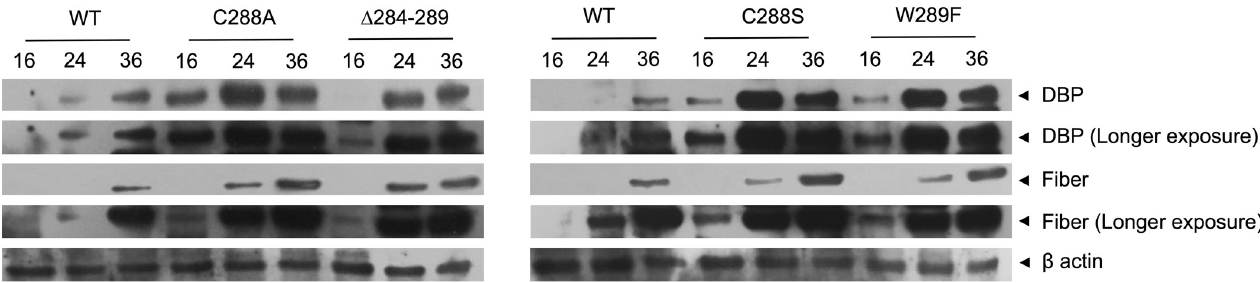
Fig 5. Effect of substitutions in the E1B 55K RNP on kinetics of accumulation of viral proteins, DBP and fiber. HFF cells infected with Ad5 WT or E1B 55K mutants were harvested at 16, 24 and 36 hpi. Total protein extracts were obtained and western blot assays were performed using the anti-DBP (B6) and anti-fiber (Abcam) antibodies. β actin (Santa Cruz Biotechnology) was used as the loading control.